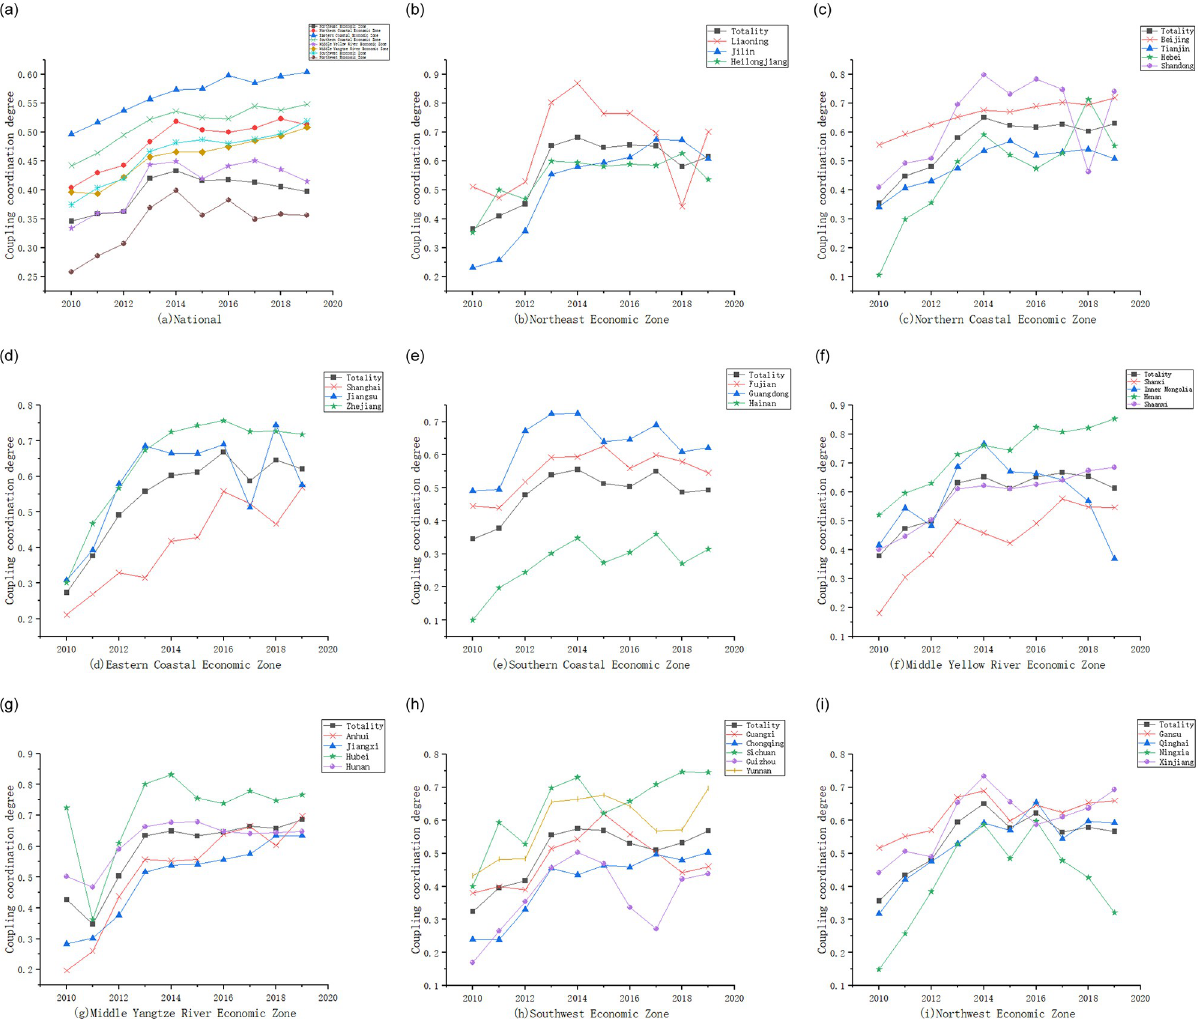
Fig 4. Coupling coordination degree of energy-economy-carbon emission systems within the eight economic regions.